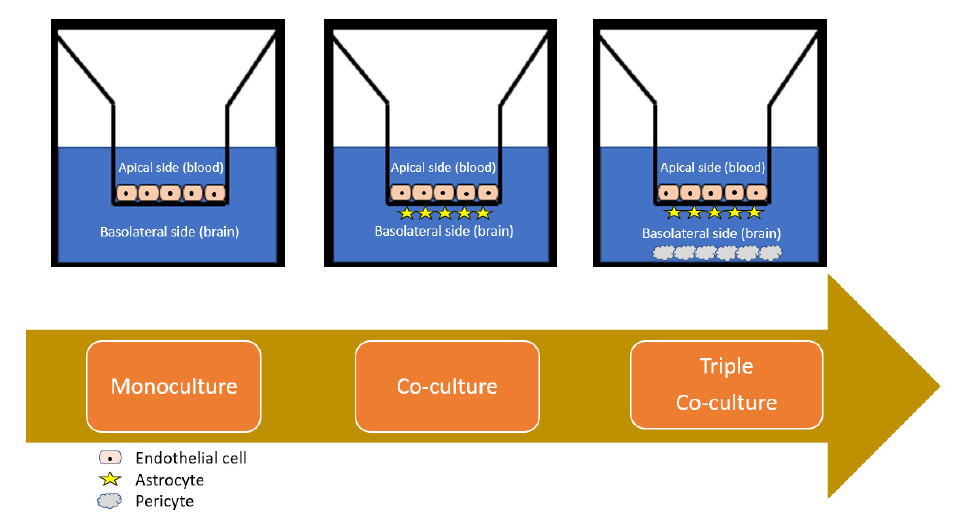
Figure 5. Co-culture models with increasing complexity and translational power from left to right. Note that the triple co-culture model comprises the essential neurovascular unit mimic with three cell types.